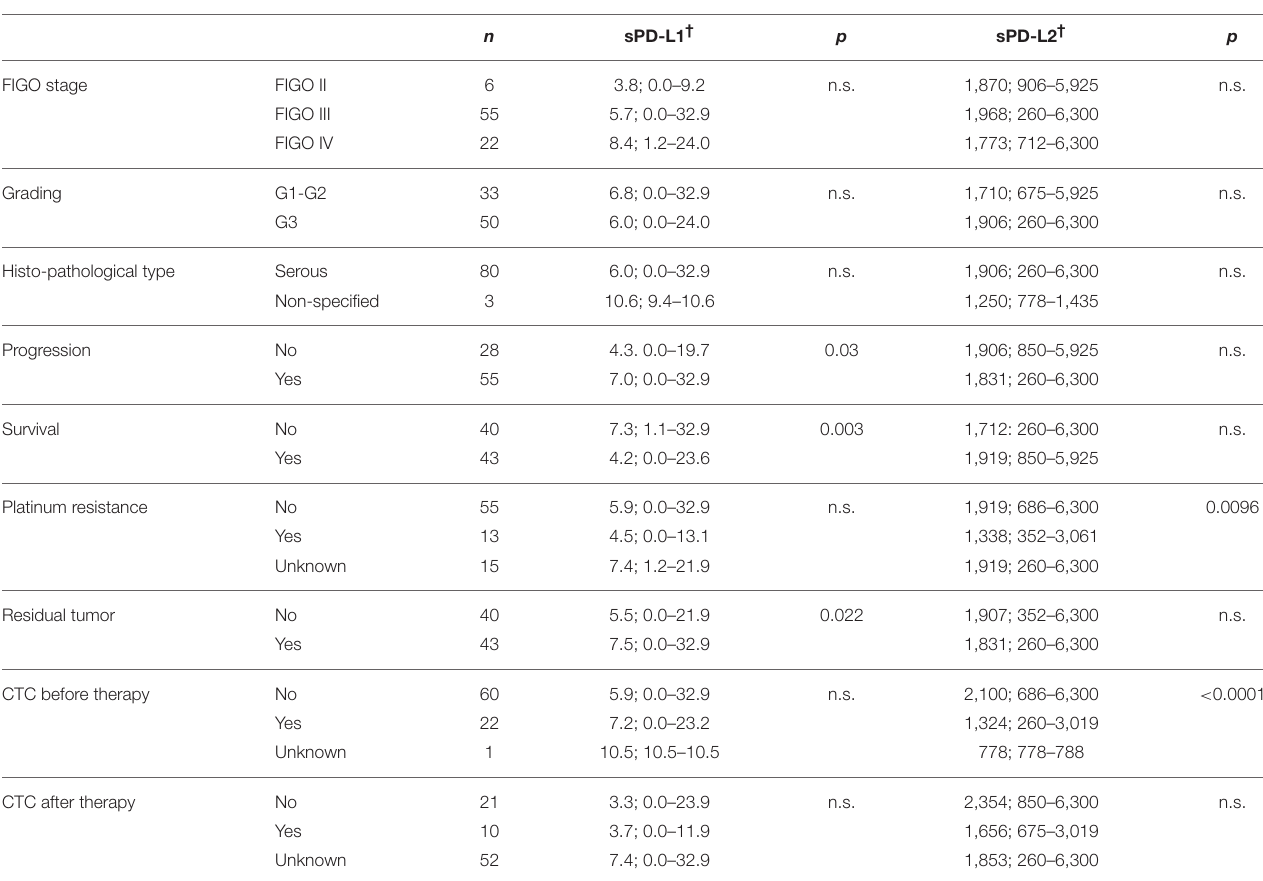
TABLE 1 | Patients’ characteristics and association to sPD-L1 and sPD-L2 serum-levels. n sPD-L1 † p sPD-L2 † p FIGO